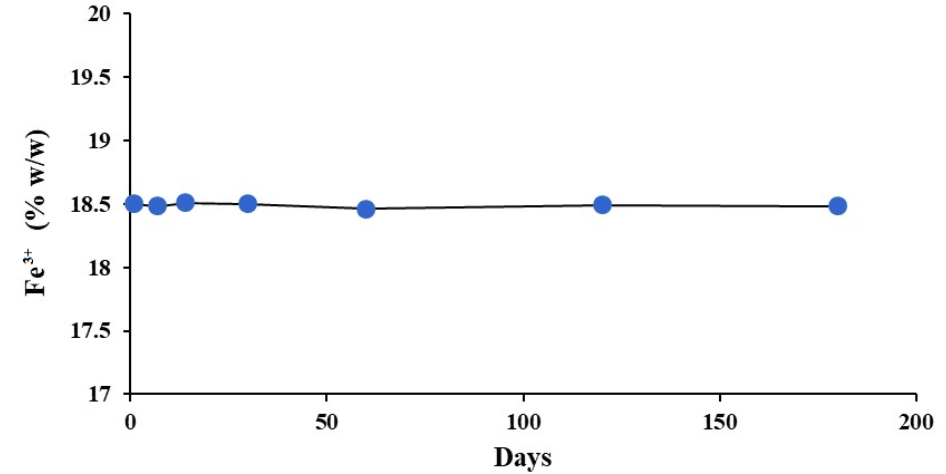
Figure 11. Fe 3+ content in the Fe(III) ‐ rhamnoxylan complex over a period of six months stored at 50 ± 1 °C and 75% relative humidity.